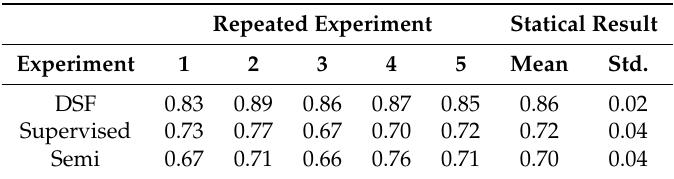
Table 14. Statistical